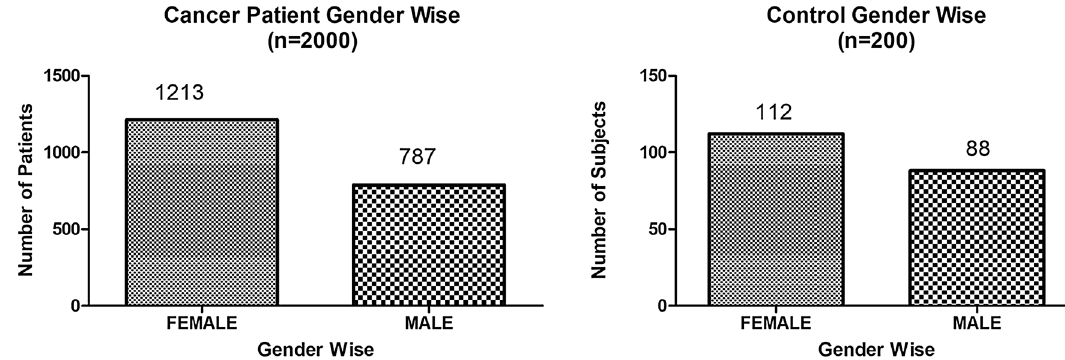
Figure 1. Graph showing number of patients (gender wise) in cancer patients and control subjects (ANOVA- Dunnett’s Test, P < 0.05).